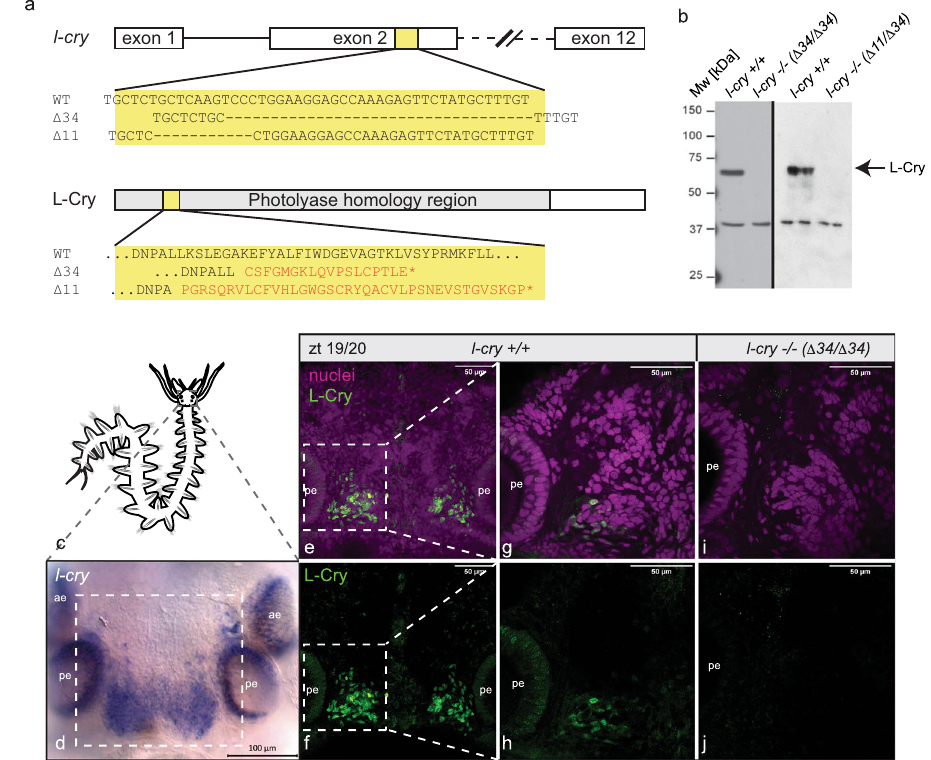
Fig. 1 | l-cry – / – mutants are loss-of-function alleles. a Overview of the l-cry genomiclocusforwtand mutants.Both mutantallelesresultinanearly frameshift and prematurestop codons.The Δ 34allele hasanadditional9bp deletion inexon 3. b Western Blots of P. dumerilii heads probed with anti-L-Cry antibody. In the context of further investigations such Western blots of mutant versus wild types have been performed more than 10 times with highly consistent results. Also see further analyses in this manuscript and ref. 36. c overview of P. dumerilii . d whole mountinsituhybridizationagainstl-crymRNAon wormhead.ae, anterioreye;pe,